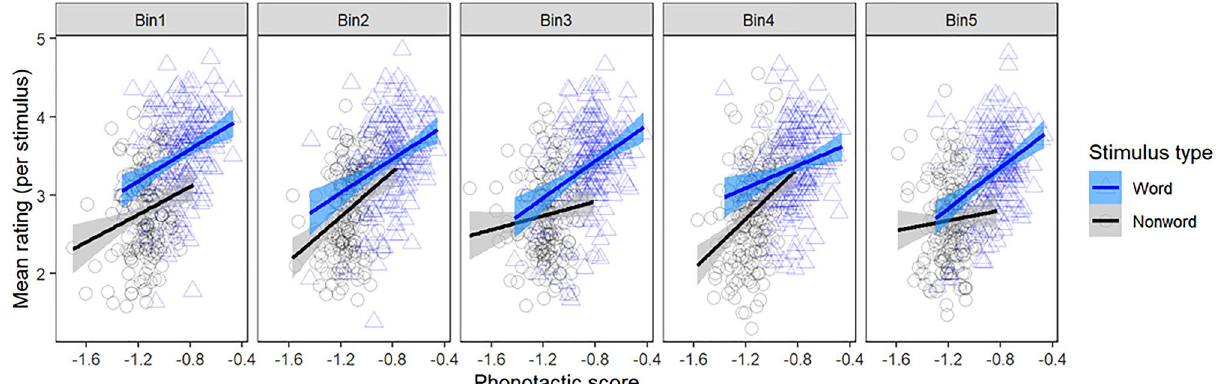
Figure 1. Non-Māori-speakers’ mean wordhood confidence ratings for each stimulus per frequency bin, and their relation to phonotactic score. Bin1 contains the most frequent real words and Bin5 contains the least frequent real words, together with their paired nonwords. Points represent mean ratings for each real word (blue) and nonword (black) within each bin, and straight lines show correlations with phonotactic scores. Across all bins, real words receive higher ratings than non-words, and items with higher phonotactic scores receive higher